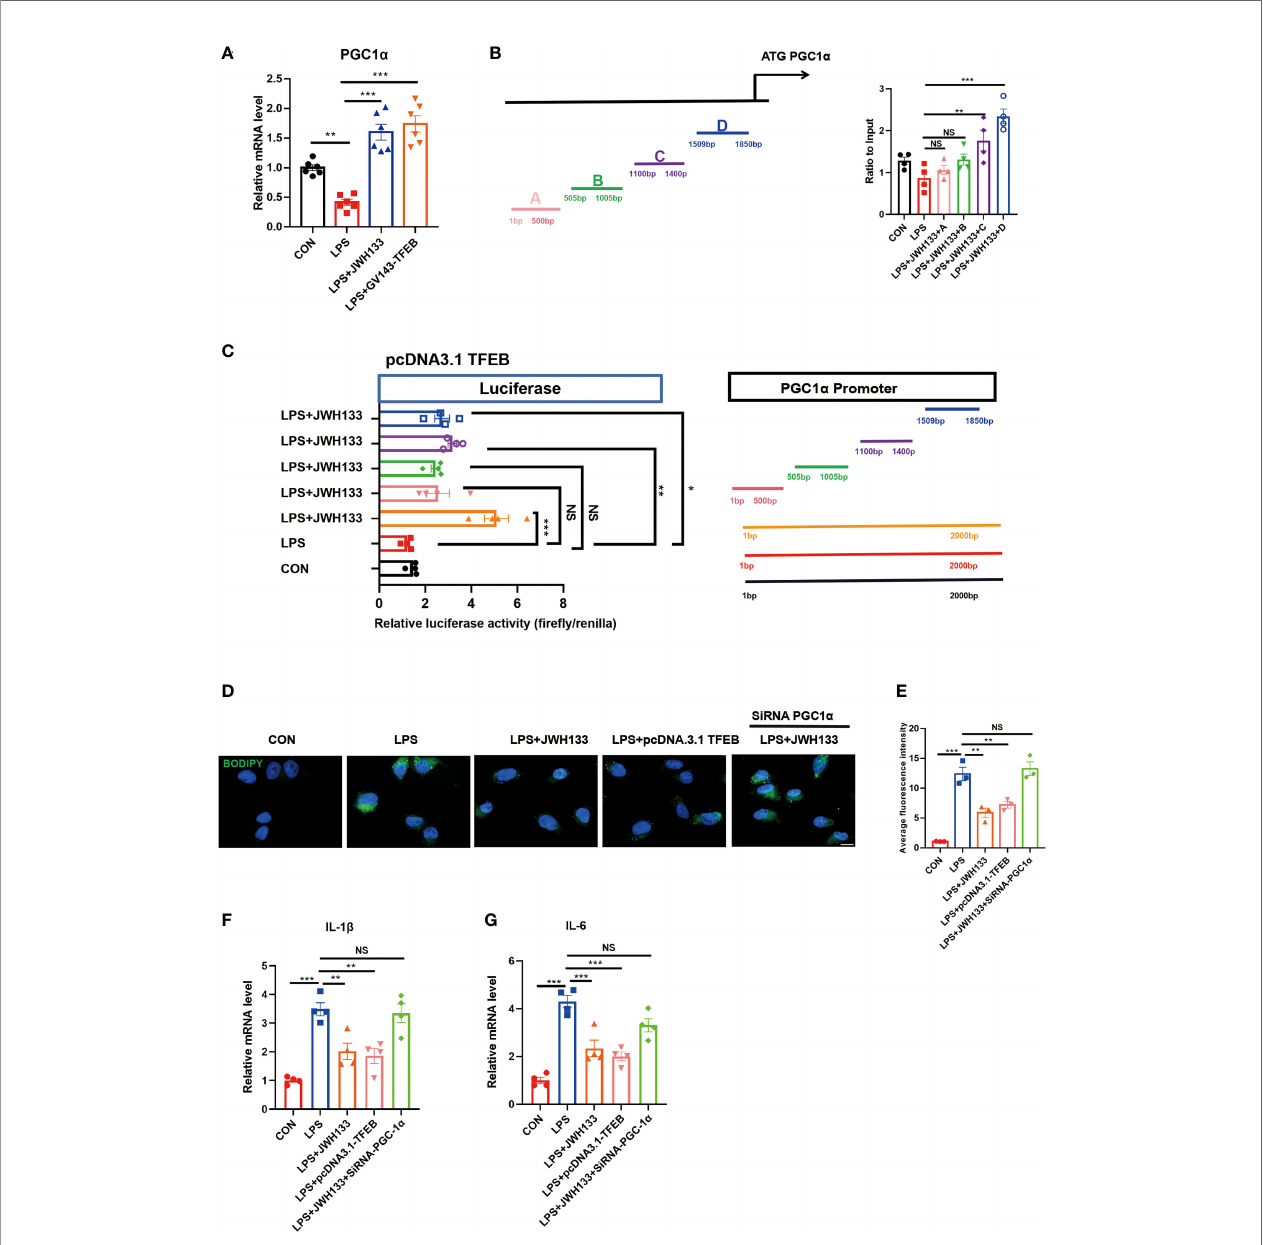
FIGURE 6 | Transfection of GV143-TFEB plasmid into U87 cells. (A) After treatment of cells with LPS and JWH133, mRNA is extracted from U87 cells and PGC-1 expression is detected by Q-PCR (means±SEM, for 6 independent experiments). (B) ChIP analysis of U87 cells. (means±SEM, for 4 independent experiments). (C) Representative diagrams of constructs containing the PGC1 a promoter region with either the intact or truncated promoter region of PGC1 a . Luciferase activity measured after transfecting increasing amounts of TFEB-Flag combined with PGC1 a plasmids (means±SEM, for 4 independent experiments). (D, E) U87 cells transfected with the TFEB- fl ag plasmid or mediated by PGC1 a expression, processed with LPS and JWH133, and stained with BODIPY. Data shown in the fi gure. (means±SEM, for 3 independent experiments). (F, G) Q-PCR analysis of IL-1 b and IL-6 (means±SEM, for 4 independent experiments). NS means not signi fi cant, * P < 0.05, ** P < 0.01, *** P < 0.001 compared with the corresponding group, as determined by